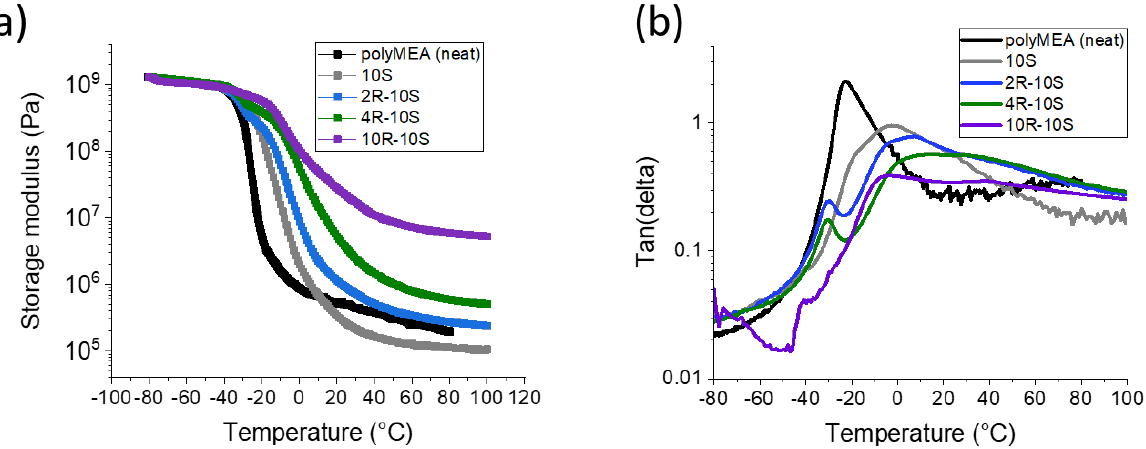
Figure 5. Effect of clay (RDS, acting as physical crosslinker) on thermo-mechanical properties: DMTA analysis of neat polyMEA, of polyMEA doped with 10 mol% of SMA (10S) and of nanocomposites with 2, 4, and 10 wt.% of RDS clay doped with 10 mol% of SMA (2R-10S, 4R-10S and 10R-10S, respectively): ( a ) curves of the temperature-dependence of storage shear moduli (G’); ( b ) curves of the temperature-dependence of the loss factor tan(delta).